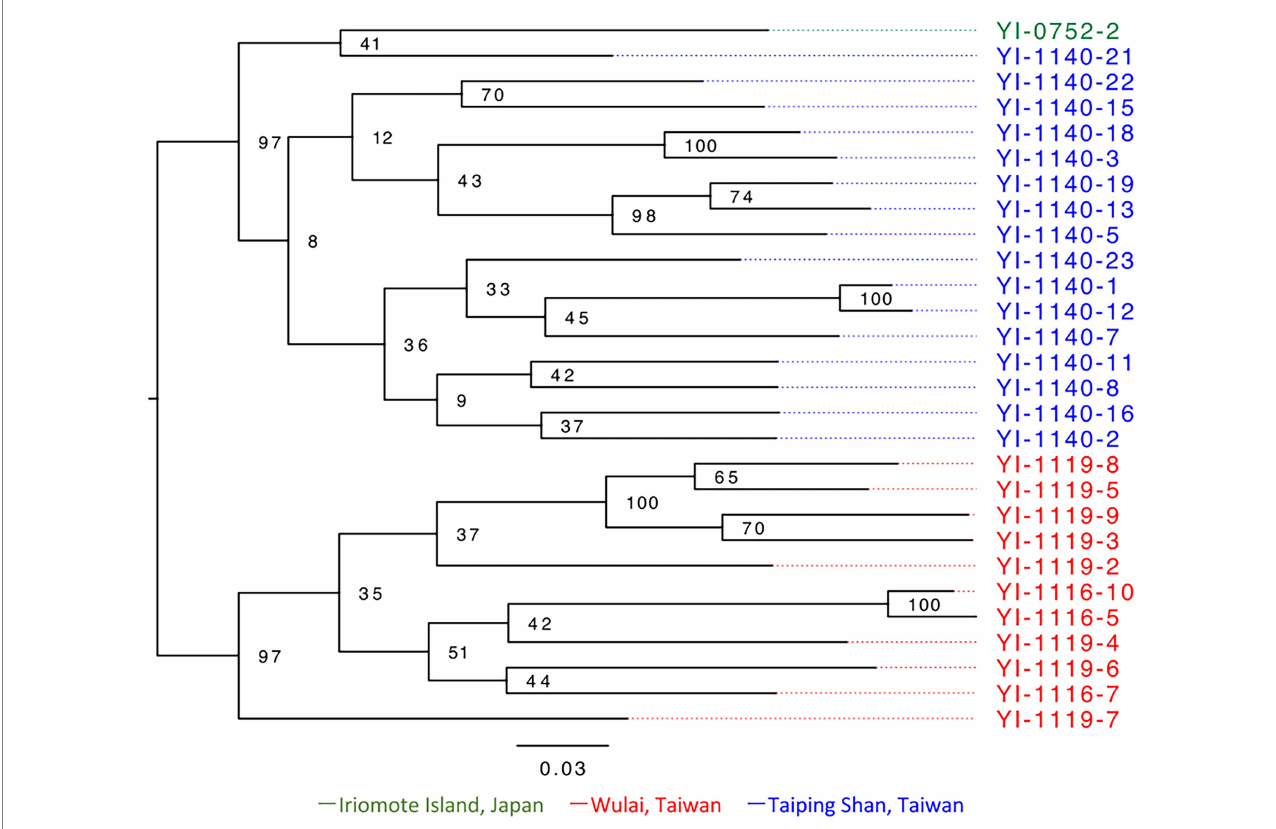
FIGURE 4 Phylogenetic analysis based on 3,539 SNPs of E. platyphyllum samples which represents the genet groups. This figure was generated by RAxML-NG and visualized by FigTree version 1.4.4. The numbers at the nodes indicate bootstrap support. Sample numbers are color-coded by population; green is for Iriomote Island, red is for Wulai, and blue is for Taiping Shan.